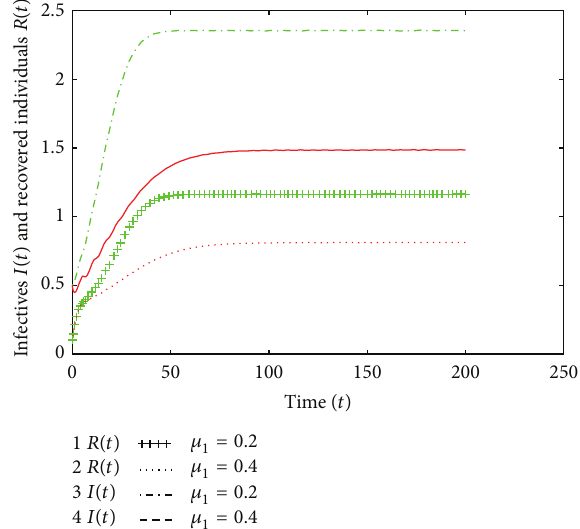
Figure 3: Variation of infective population 𝐼(𝑡) and recovered population 𝑅(𝑡) with time for different values of 𝜇 1